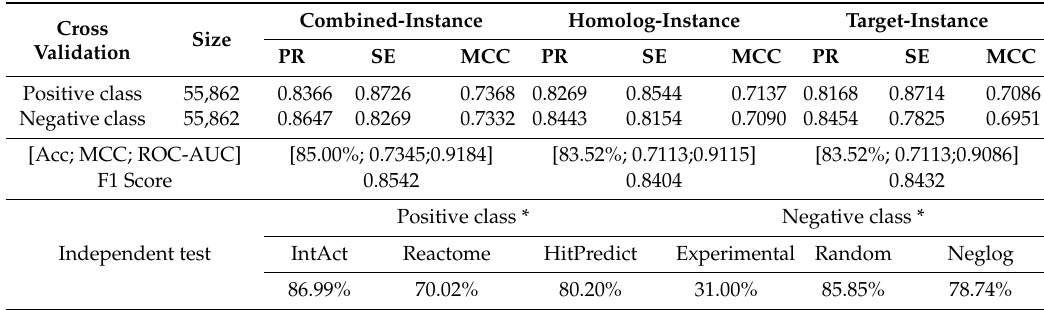
Table 2. Random sampling method performance of five-fold cross validation and independent